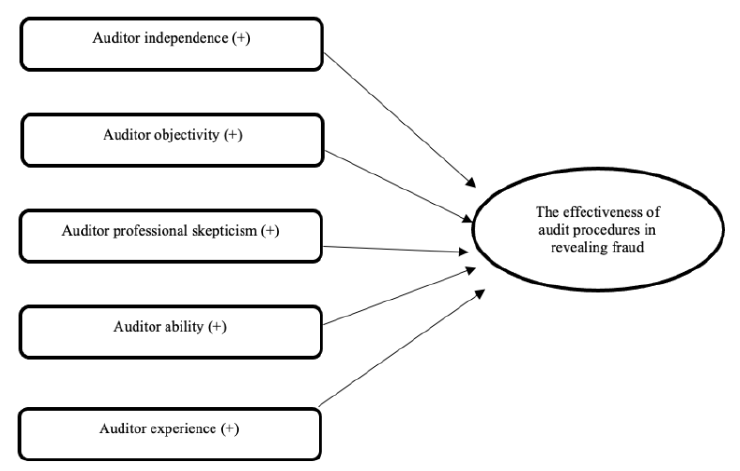
Figure 1: Frame of research; Source: Author